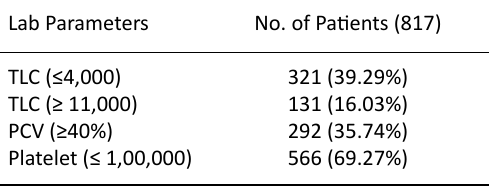
Table 1. Laboratory